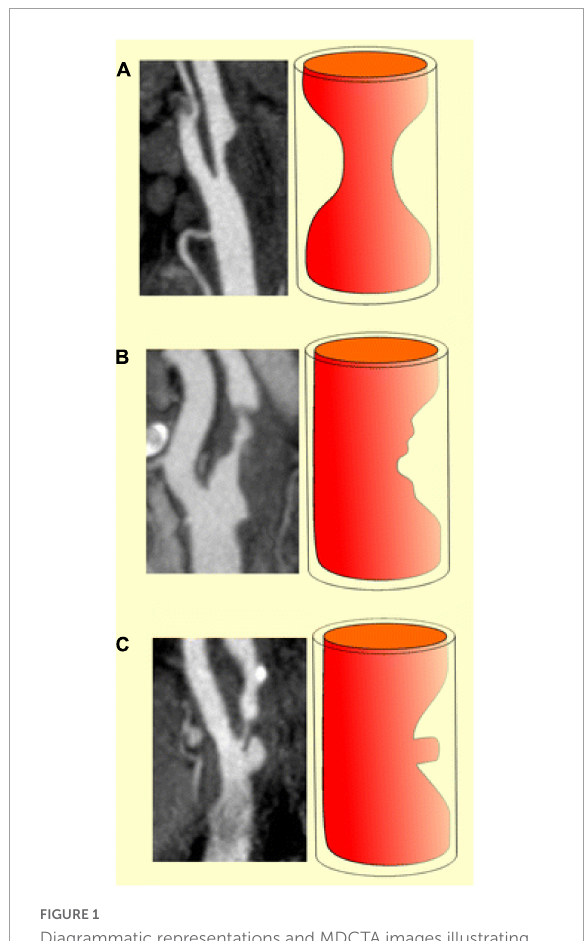
FIGURE1 Diagrammatic representations and MDCTA images illustrating the classification of carotid plaques based on their surface morphology as smooth (a) , irregular (b) and ulcerated (c) (Content copied in its original form from reference (19) under Creative Commons Attribution 4.0 International License).